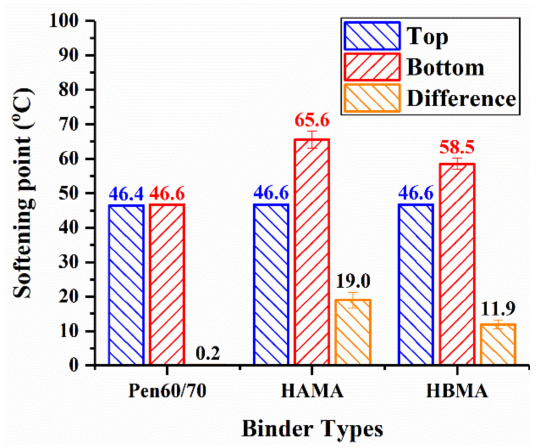
Figure 6. Storage stability test